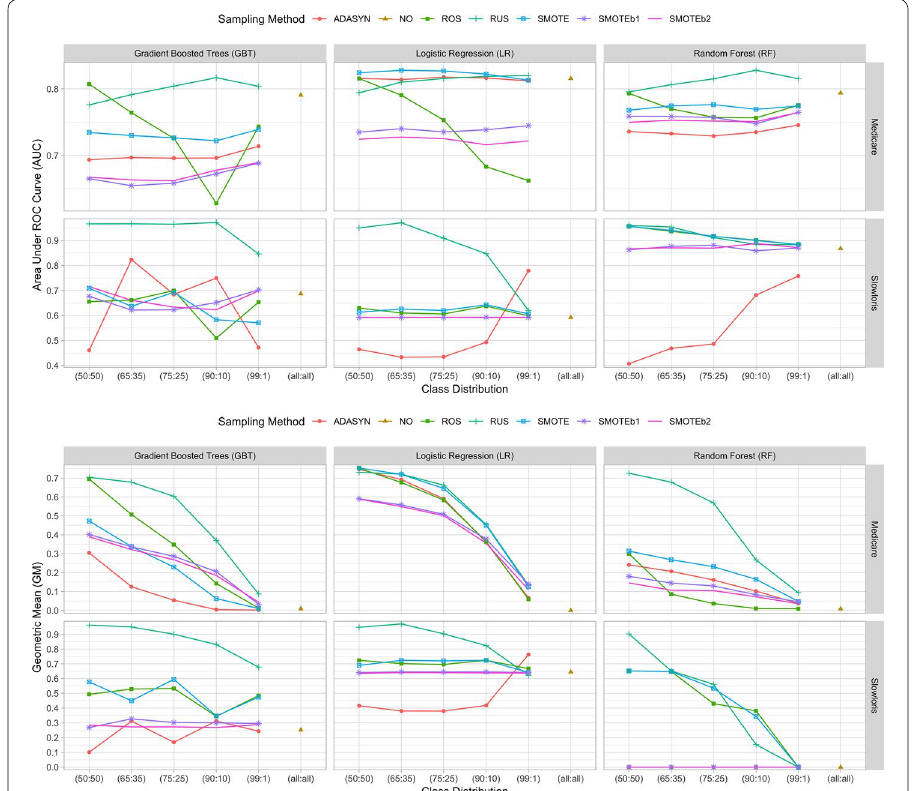
Fig. 1 Results for averages of sampling methods